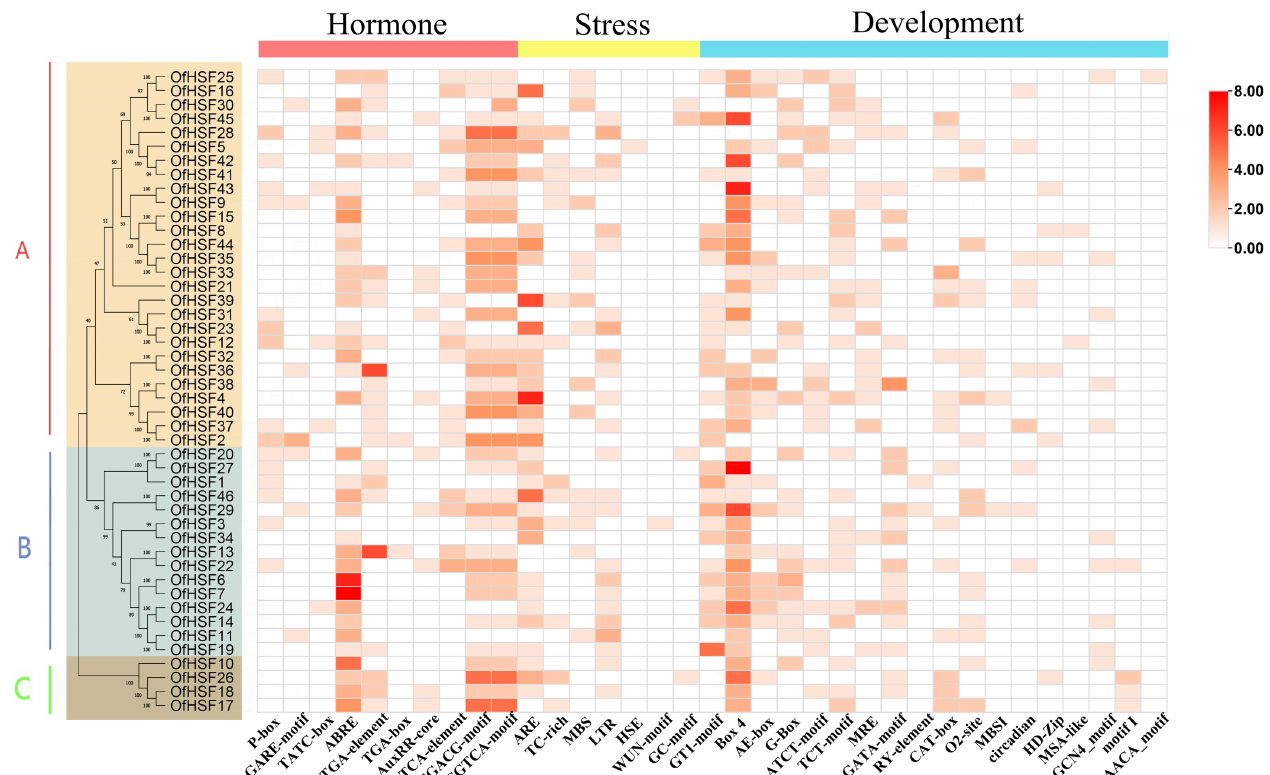
Figure 3. The cis -regulatory elements in the promoter regions of OfHSF s. The red histogram on the right of heat map indicates the corresponding number of cis -regulatory element. The red, yellow and blue rectangles represent three types of the cis -acting elements related with hormone, stress and development, respectively. The OfHSF s were divided into A, B and C subfamilies and represented by with different